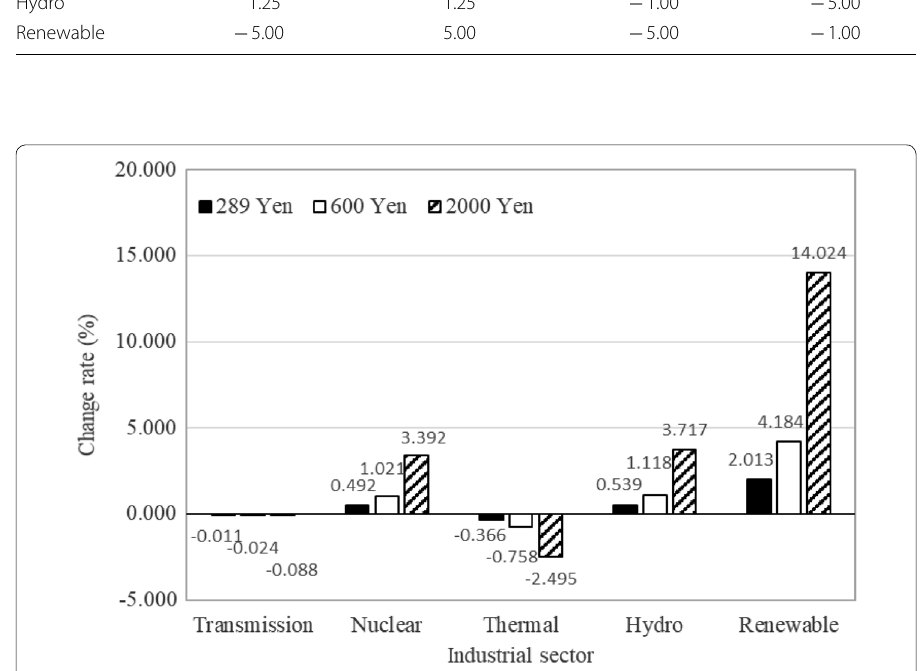
Fig. 6 The result of simulation of additional